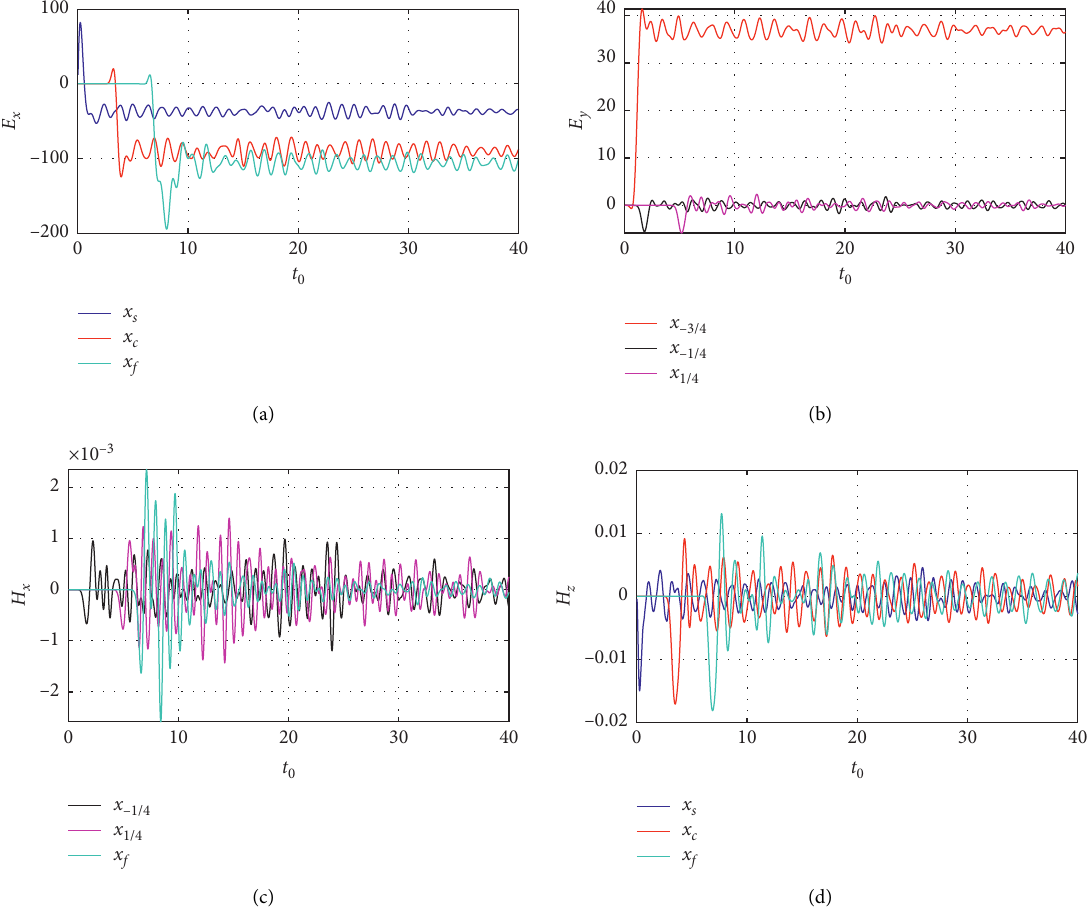
Figure 4: The time dependence for the components (a) E v � 1 . 5 and frequency ω 0